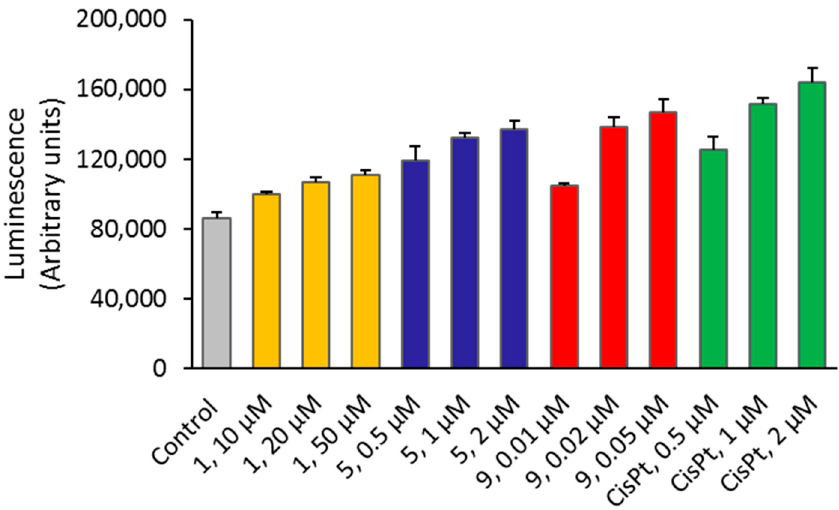
Figure 8. Caspase activity assays. Apoptosis was evaluated by CaspaseGlo assay after cell treatment for 24 h, using for each complex at concentrations below their IC 50 value. Data was expressed as the mean ± SD, in arbitrary luminescent units. Cisplatin was included for comparison. 1 (yellow), 5 (blue), 9 (red), and cisplatin (green).